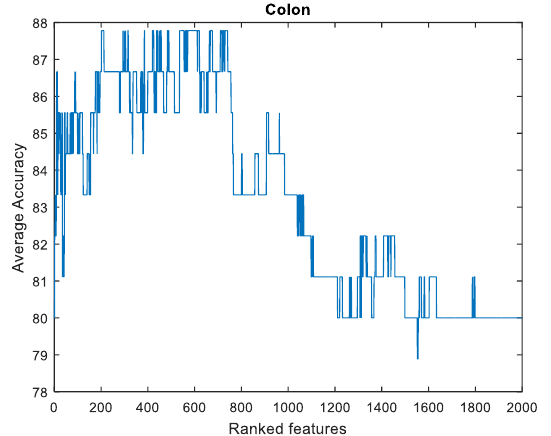
Fig. 2. The average accuracy of the ranked features for colon cancer dataset.